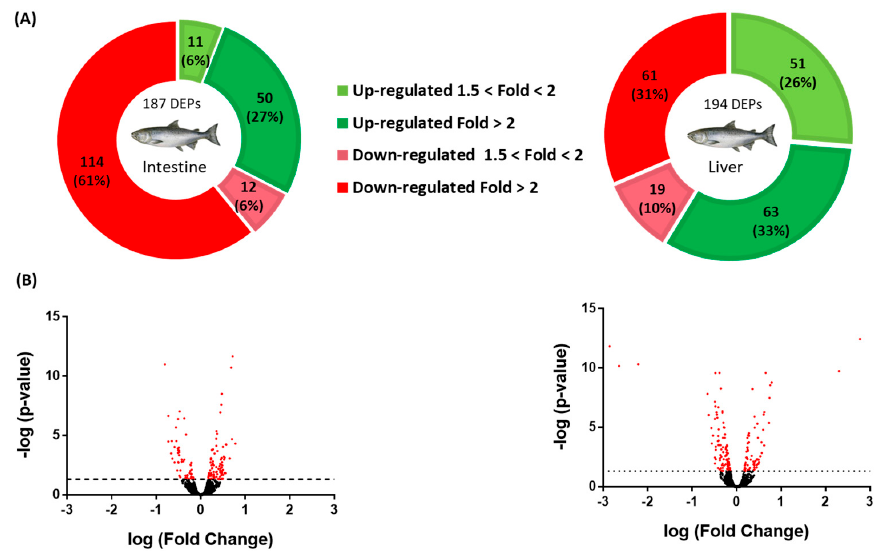
Figure 1. Analyses of differentially expressed proteins (DEPs) in the intestine and liver of salmon fed a lysophospholipid-enriched diet. ( A ) Pie charts for the intestine and liver DEPs. The green (upregulation) and red (downregulation) color scheme indicates the protein modulation according to its fold-change magnitude interval. ( B ) Volcano plots for the intestine and liver DEPs. The Volcano plots were constructed by plotting the negative logarithm of the p -value on the y-axis.